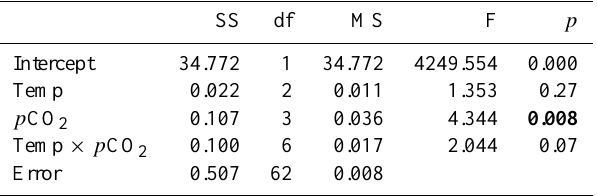
Table 5. Univariate tests of significance indicating the effect of tem- perature and p CO 2 on the ratio of shell increment to shell diameter. Significant results are represented in